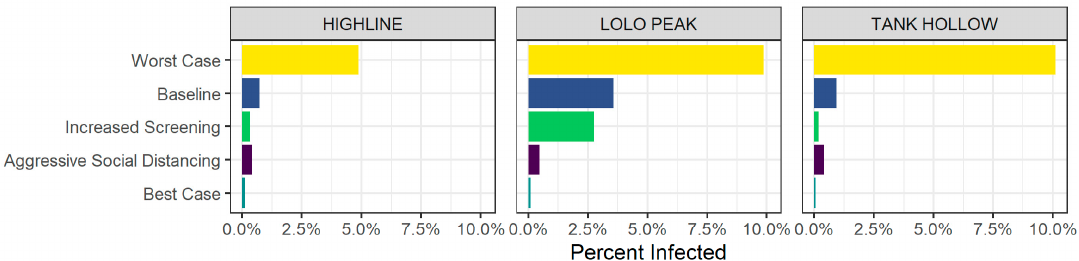
Figure 6. A comparison of the percentage of the workforce infected on the day with the largest number of personnel working across fires and scenarios.